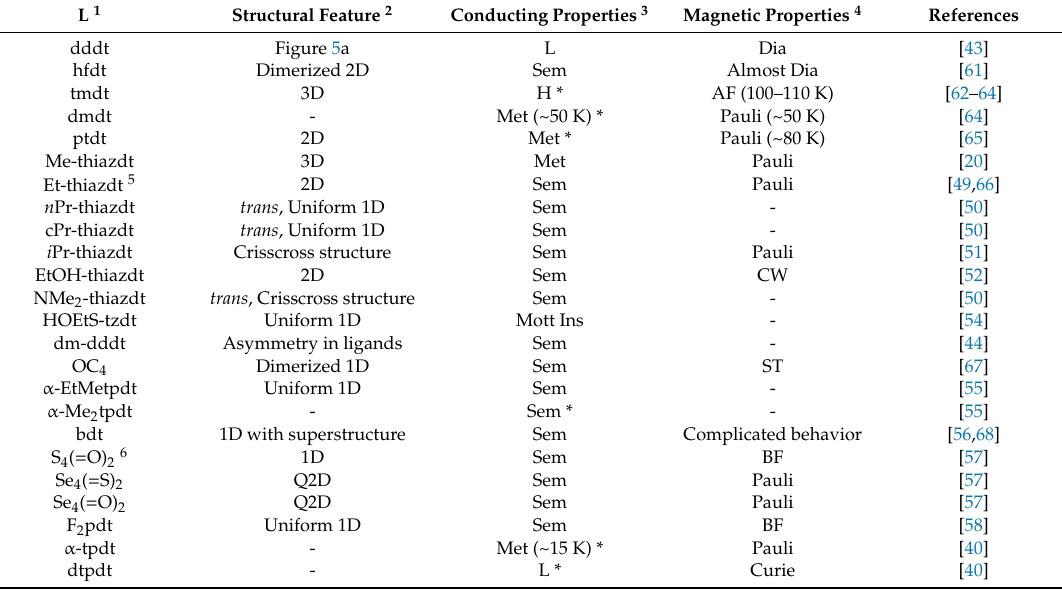
Table 2. Crystalline Gold(III)-dithiolene complexes containing neutral [Au(III)L 2